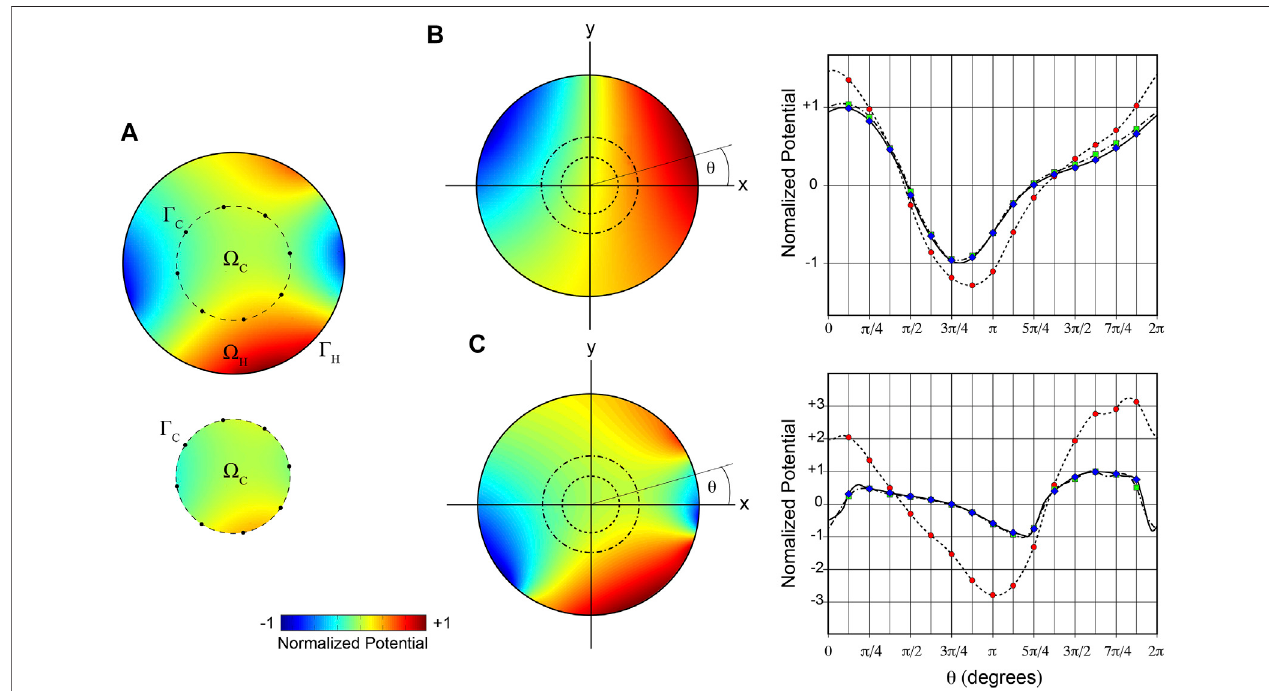
FIGURE 2 | 2D illustration of mesh-based inverse potential mapping. (A) Schematic of steps in specifying Cauchy boundary conditions on Γ C . The potential distribution in Ω H (upper panel) is sampled at 8 recording electrodes (black dots). Potentials around Γ C are reconstructed from these samples with radial basis interpolationandusedasDirichletboundaryconditionsinnumericalsolutionofpotentialdistribution in Ω C (lowerpanel).Thisenablesestimationofpotentialsandnormal potential gradients around Γ C . B and (C) Potential distributions on Γ H reconstructed from potentials sampled in Ω H for (B) relatively simple, and (C) more complex potential fi elds in Ω H . Ground-truth potential distributions in Ω H are given on left and the broken circles indicate the internal boundaries around which samples are acquired (16 sites in both cases). Potentials on Γ H are reconstructed using Cauchy boundary conditions on Γ C and compared with ground-truth potentialsin the graphs at right. Normalized ground truth surface potentials (solid line, blue diamonds), and surface potentials reconstructed from samples acquired on internal boundaries with relative radii 0.469 (dashed line, green squares) and 0.375 (dotted line, red circles) are plotted as functions of angular coordinate θ .